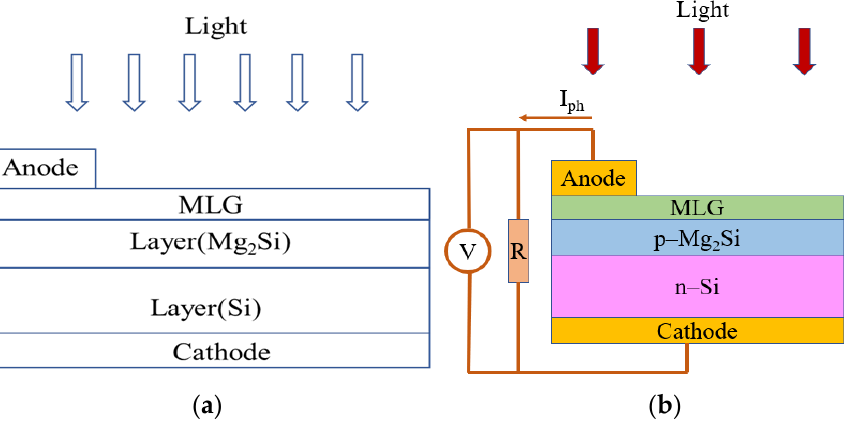
Figure 1. ( a ) The schematic of the experimental fabrication of the MLG/Mg 2 Si/Si PD; ( b ) the measurement circuit of detection properties of the MLG/Mg 2 Si/Si PD.